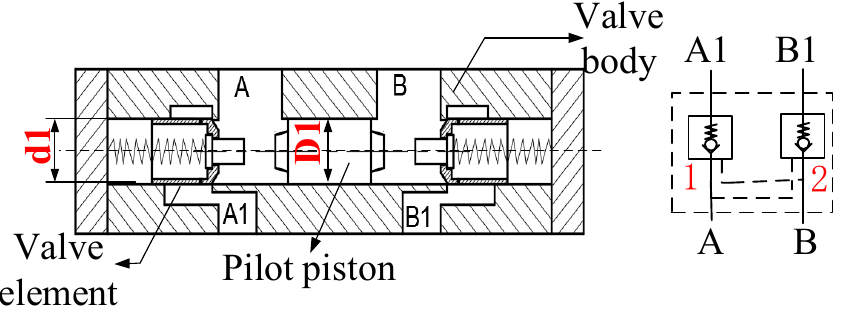
Figure 5. The mechanical structure and the symbol of the hydraulic lock.